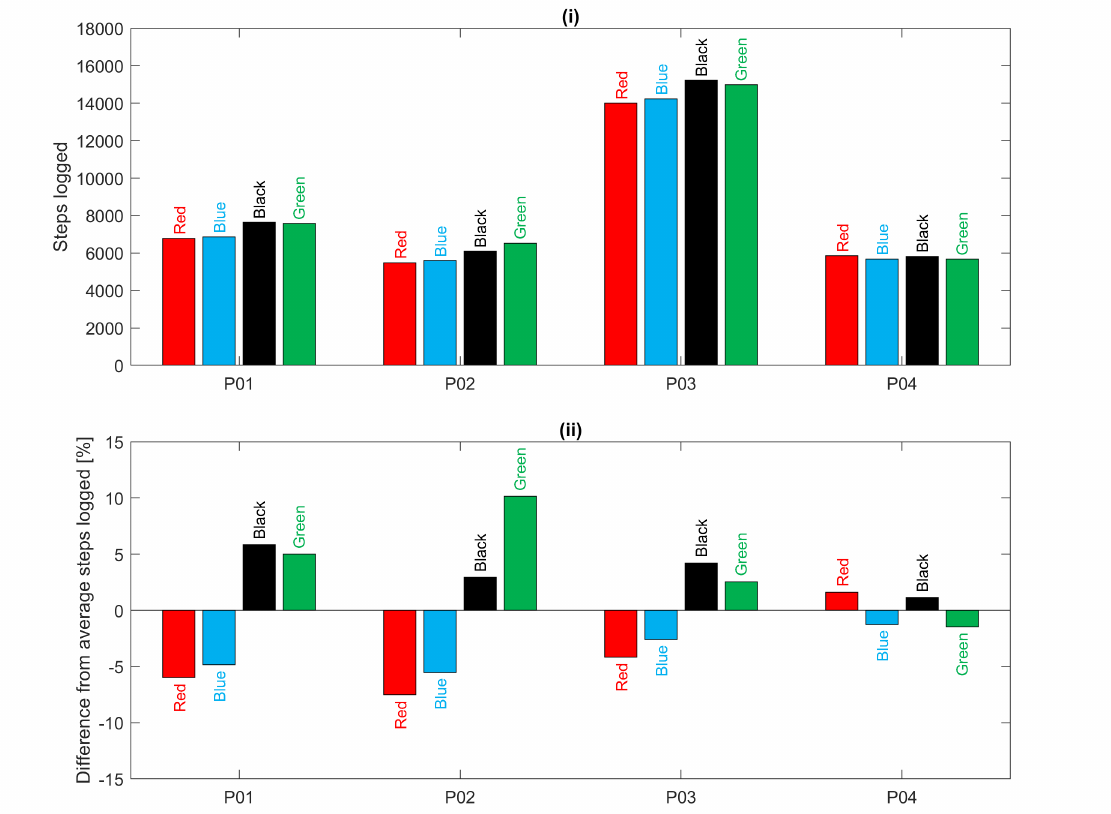
Figure 9. Total steps logged over 12 h of everyday living, ( i ) absolute totals logged by each device for each participant, ( ii ) percentage difference of device totals relative to the average logged step count for each